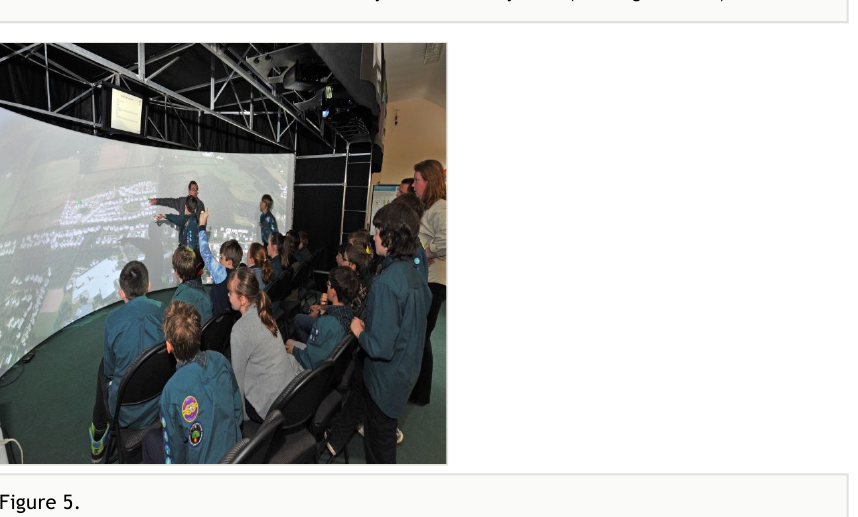
Figure 5. VRT based stakeholder evaluation adjacent to the area (Aboyne,